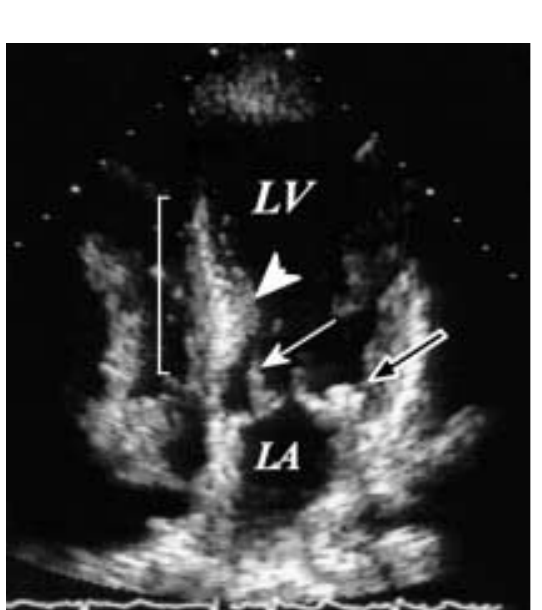
12 lead ECG (10 mm/mV; 25 mm/sec) showing a regular sinus rhythm, an atrioven- tricular conduction delay of 200 msec, an amputated R wave on the right precor- dial leads, with a diffuse low voltage (<0,5 mV).